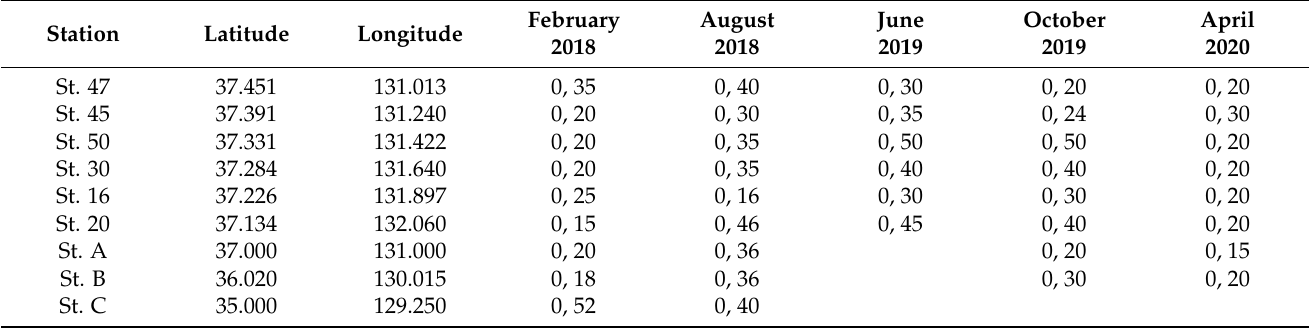
Figure 1. Station Map. The red circles on the map represent sampling stations. Stations A, B, C are reference stations. Table 1. Research stations and sampling depths (m) surveyed during each cruise. Surface water and SCM-layer water were sampled.